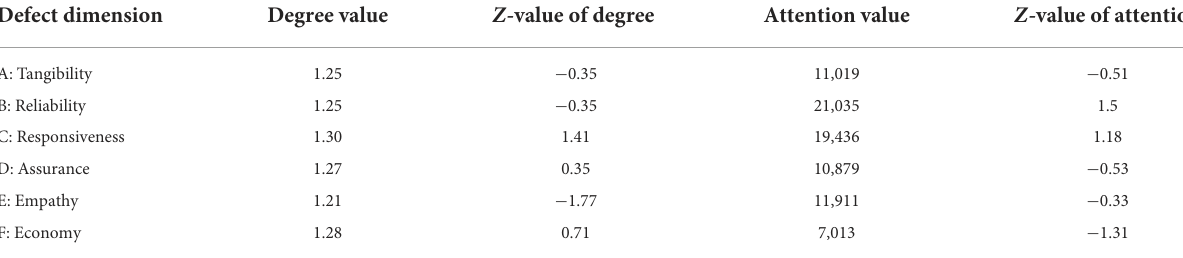
TABLE 5 The results of degree value and attention value of express service defect. Defect dimension Degree value Z -value of degree Attention